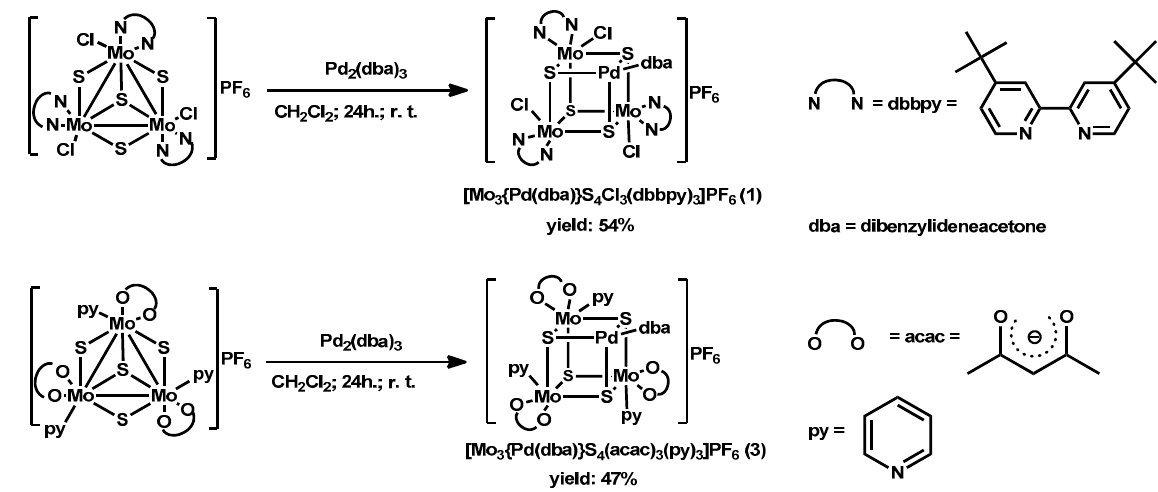
Scheme 1. Synthesis of cubane-type cluster complexes 1 and 3